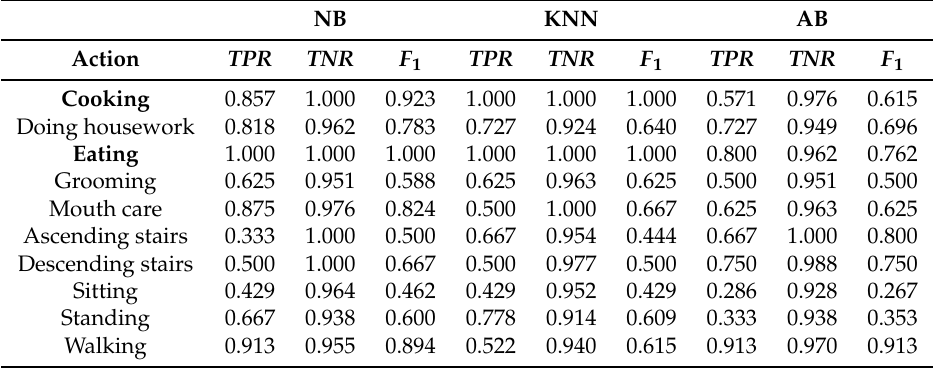
Table 3. Classification results for each action using High-level features extracted with the dynamic approach. KNN: K-nearest neighbours, NB: Naive Bayes, and AB: AdaBoost inference algorithms. NB KNN AB